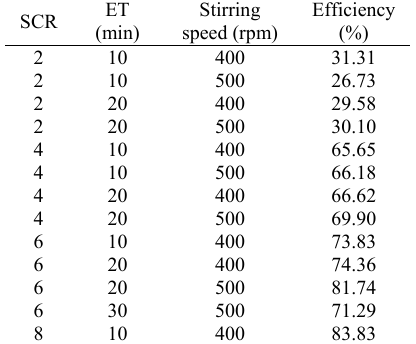
Table 3: Efficiencies obtained in different SCRs and ETs